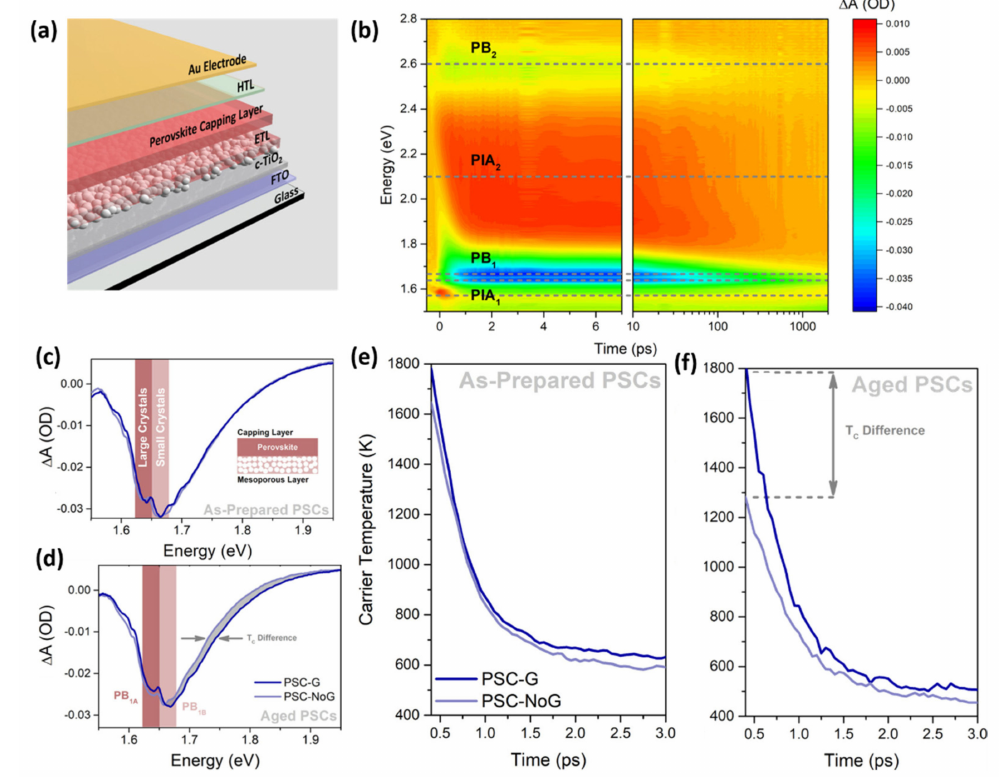
Figure 2. ( a ) Schematic illustration of the architecture of the investigated PSCs. ( b ) Two-dimensional false color map of transient absorption signal of the as-prepared PSC-G. Comparison of the transient absorption signal in the PB 1 region for ( c ) as-prepared and ( d ) one-week aged PSC-G and PSC-NoG. Comparison of the carrier temperature as a function of time delay for ( e ) as-prepared and ( f ) one- week aged PSC-G and PSC-NoG. Figures adapted from ref. [64]. Copyright American Chemical